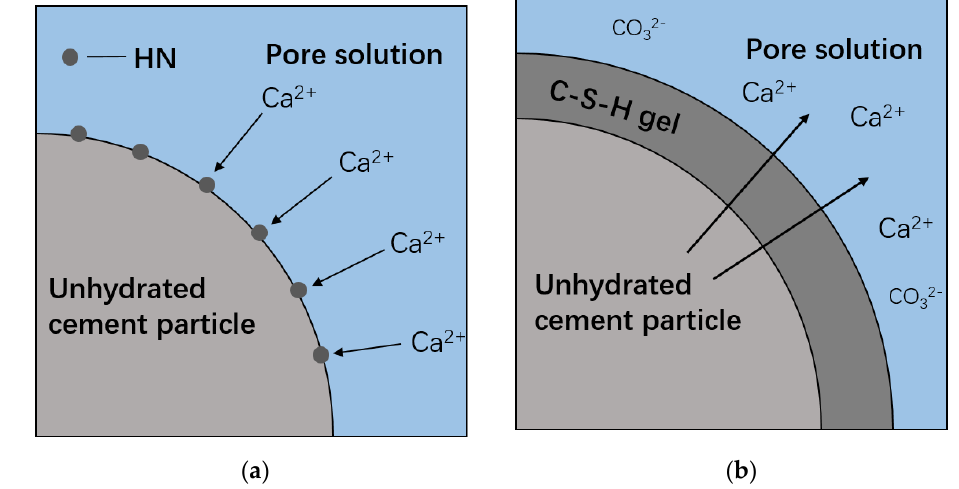
Figure 8. Schematic diagram of Ca 2+ migration: ( a ) during hydration and ( b ) during carbonation.